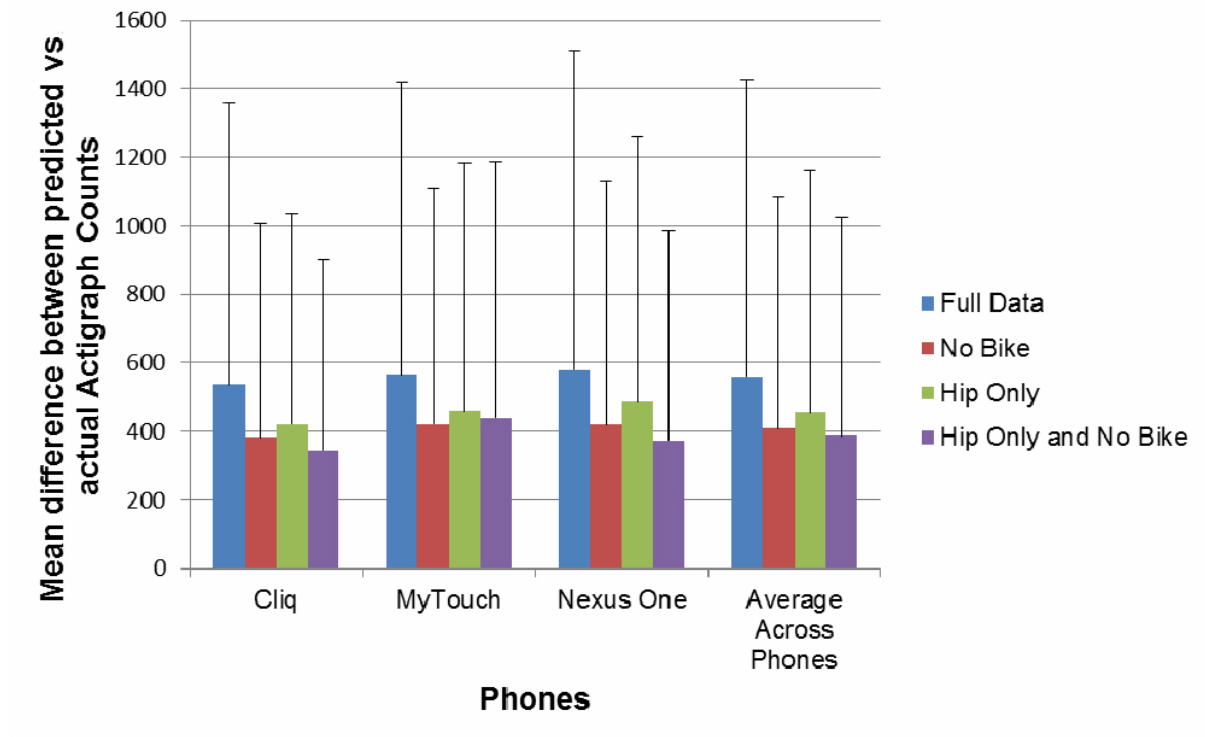
Figure 2. Comparison of the stability of different regression model estimates (laboratory study). The error bars represent the root mean standard error across all models run utilizing a leave one out procedure.